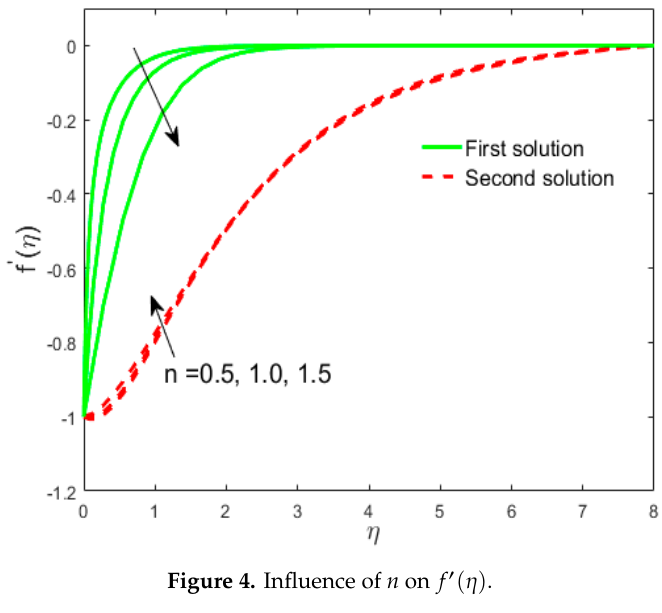
Figure 4. Influence of n on